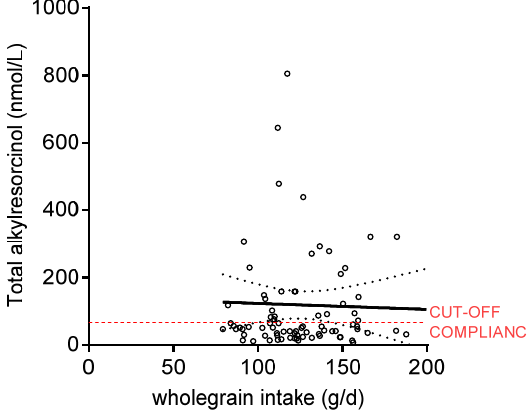
Figure 3. Correlation between reported mean whole-grain intake (g/day) during the 12-week dietary intervention and plasma alkylresorcinol concentration (nmol/L) measured at visit 4 with 95% confidence intervals for participants in the WG group ( n 81).